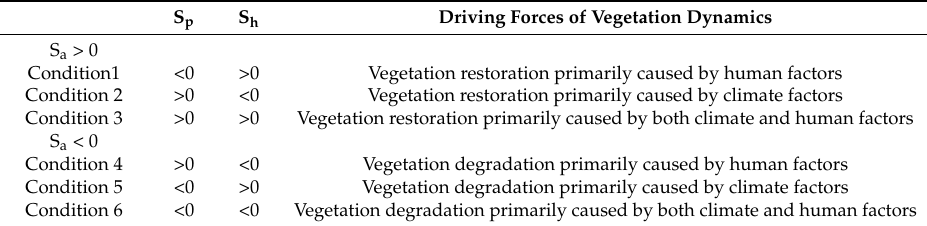
Table 1. Conditions that indicate the driving forces of vegetation